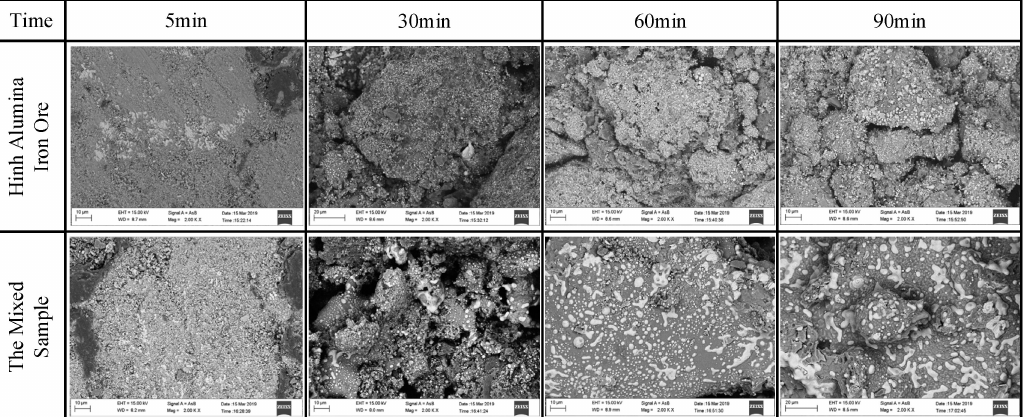
Figure 10. Micrographs of the reduced samples at 1200 ◦ C under FC/O of 1.0 for different reduction times.